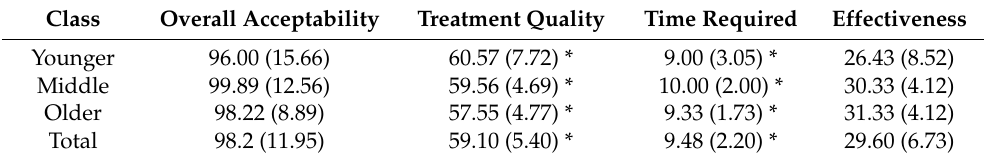
Table 2. TEQ-P Results ( N =